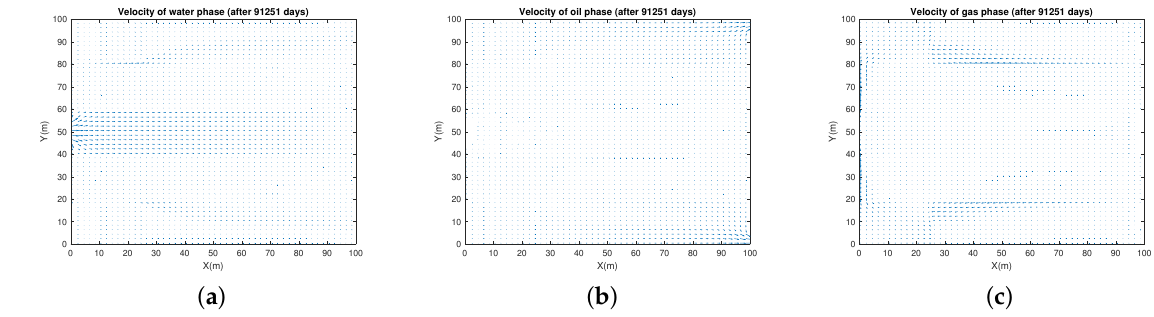
Figure 16. Darcy velocity fields of water ( a ), oil ( b ), and gas ( c ).